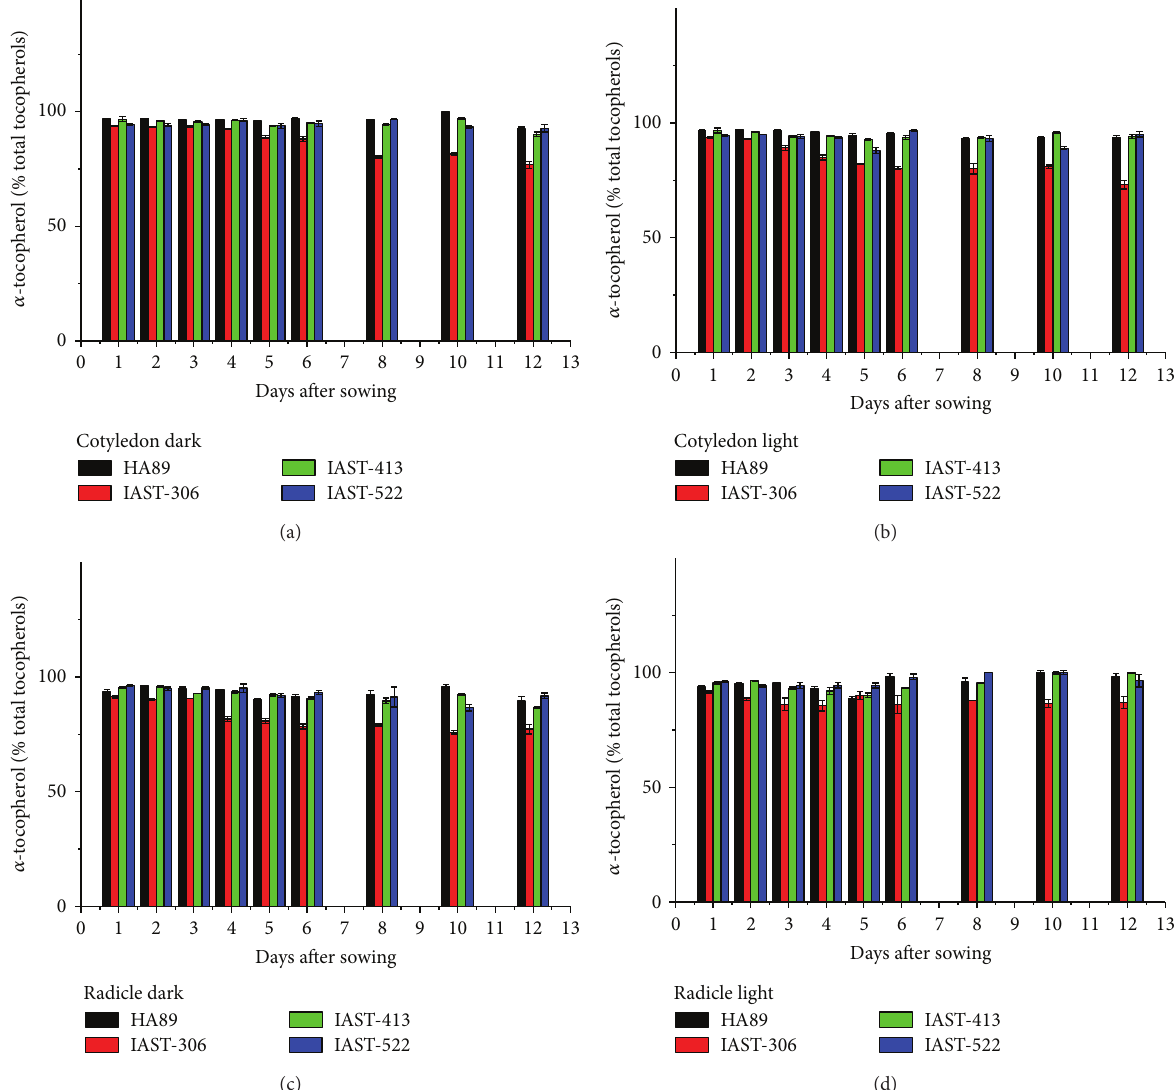
Figure 2: Proportion of 𝛼 -tocopherol (% total tocopherols) from 1 to 12 days after sowing in cotyledons and radicles of sunflower lines HA89, IAST-306, IAST-413, and IAST-522, with contrasting levels of seed tocopherol content predominantly in the 𝛼 -tocopherol form, from seedlings grown under dark and light conditions. Data are presented as mean ± standard error of three